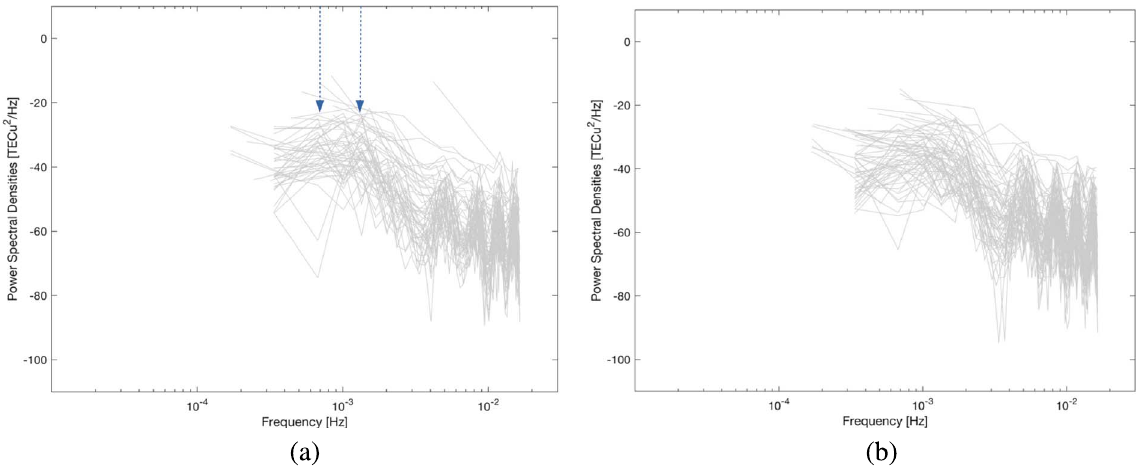
Fig. 16. Power spectral densities of all the TEC residuals considered during the hours: (a) 20:00 – 21:00 UT and (b) 21:00 – 22:00 UT. The arrows indicate the two components considered in the